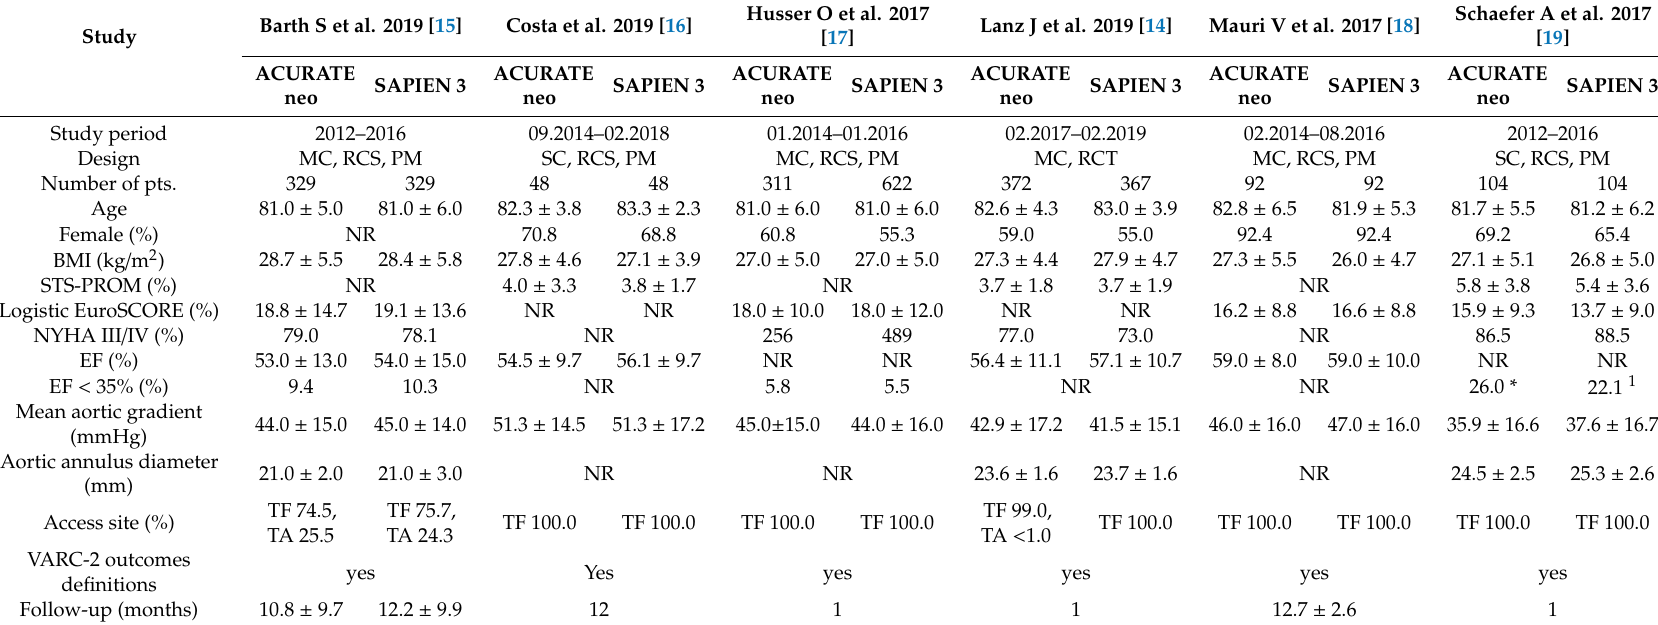
Table 2. Baseline characteristics of included